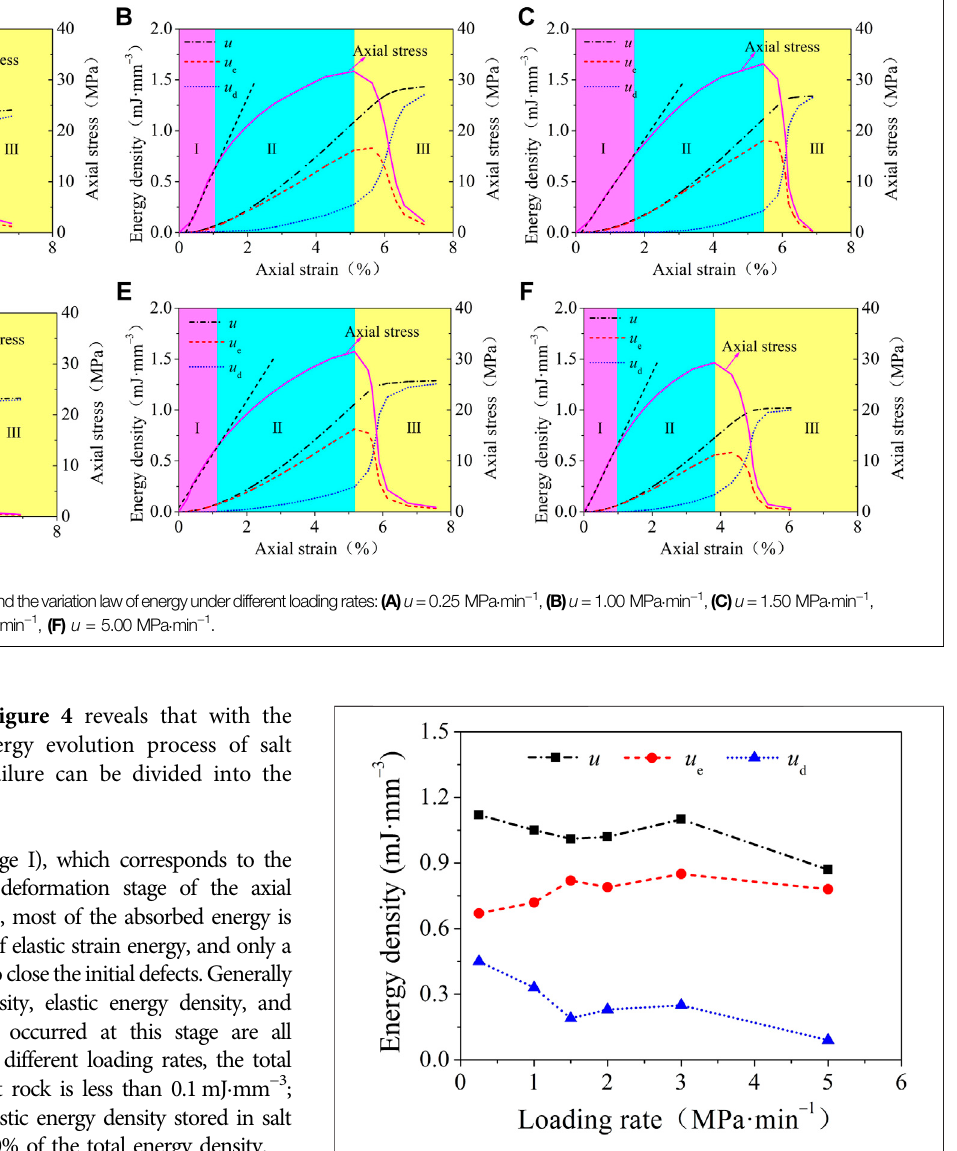
FIGURE 5 | Relationship between energy density and loading